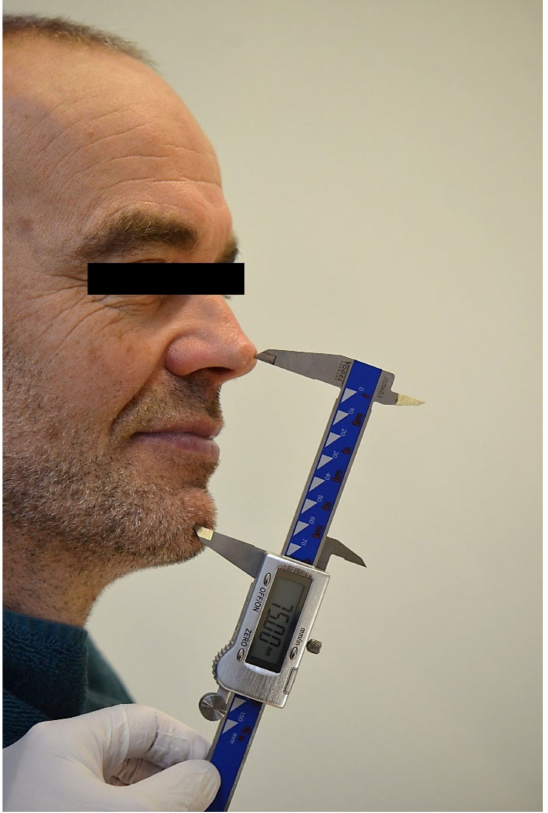
Figure 3. The patient was asked to close with the full-arch fixed implant prosthesis in place, and the distance between a pen dot on the patient’s nose and chin was measured with a digital